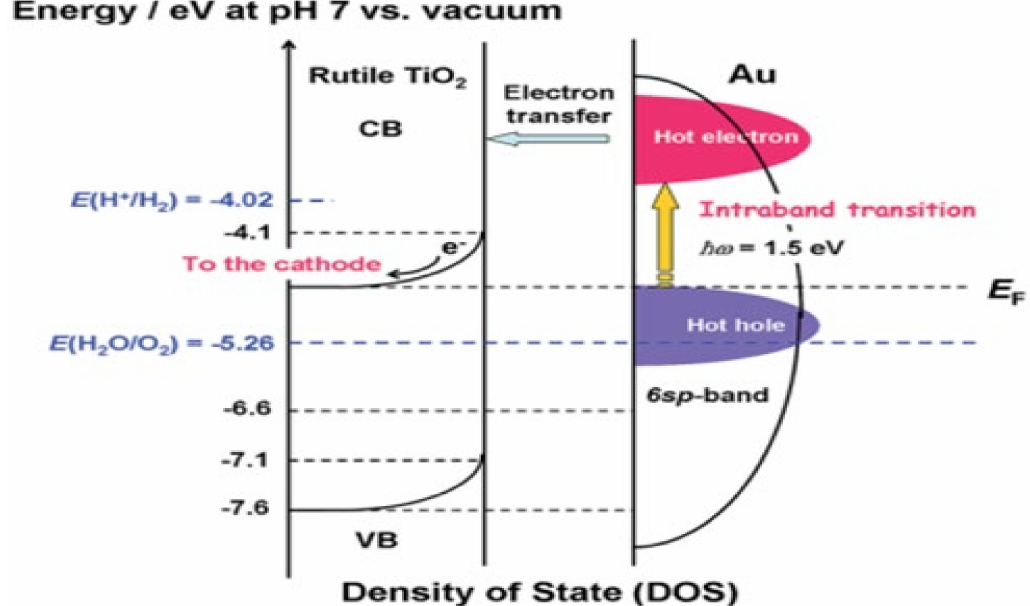
Figure 55. Schematic representation of the energy diagram of the Au/TiO 2 plasmonic electrode with the density of states of TiO 2 and energy distribution of the hot carriers in Au NPs with the intraband transition through the surface plasmon decay. Reproduced with permission from Nano scale Adv. [455], Copyright 2019,